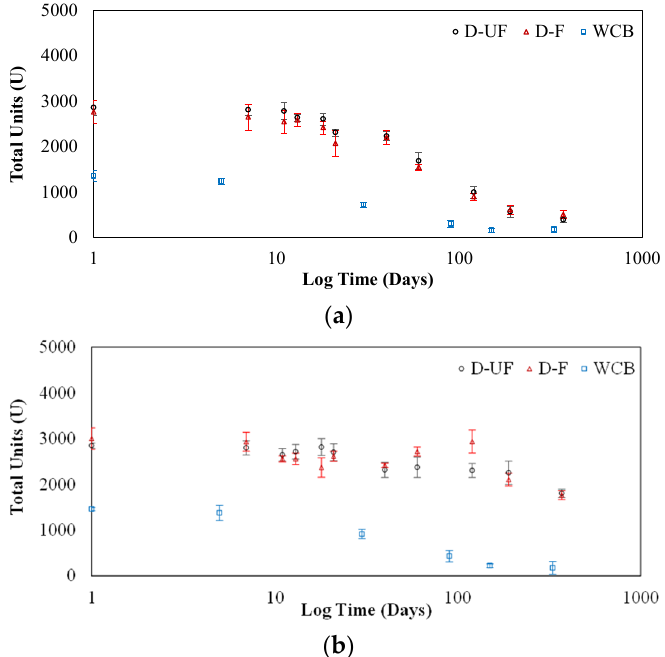
Figure 2. Urease activity measurement determined at different storage times for three different sources of prepared crude extract at ( a ) room temperature and ( b ) 4 °C. (D-UF) Dehusked Unfiltered, (D-F) Dehusked Filtered, (WCB) Whole Crushed Beans.